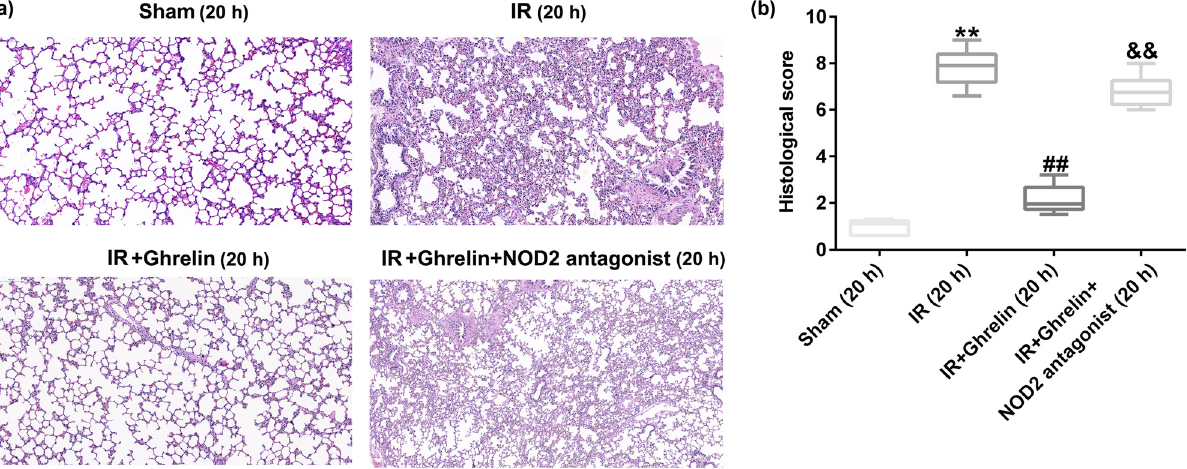
Figure 6: NOD2 antagonist reversed the e ff ects of ghrelin on lung tissue damage. ( a ) Lung tissue samples from rats of di ff erent groups were stained with hematoxylin and eosin. ( b ) The histological score was determined. Data were expressed as mean ± SD, n = 6; ** P < 0.01 vs sham; ## P < 0.01 vs IR; and P < 0.01 vs IR +